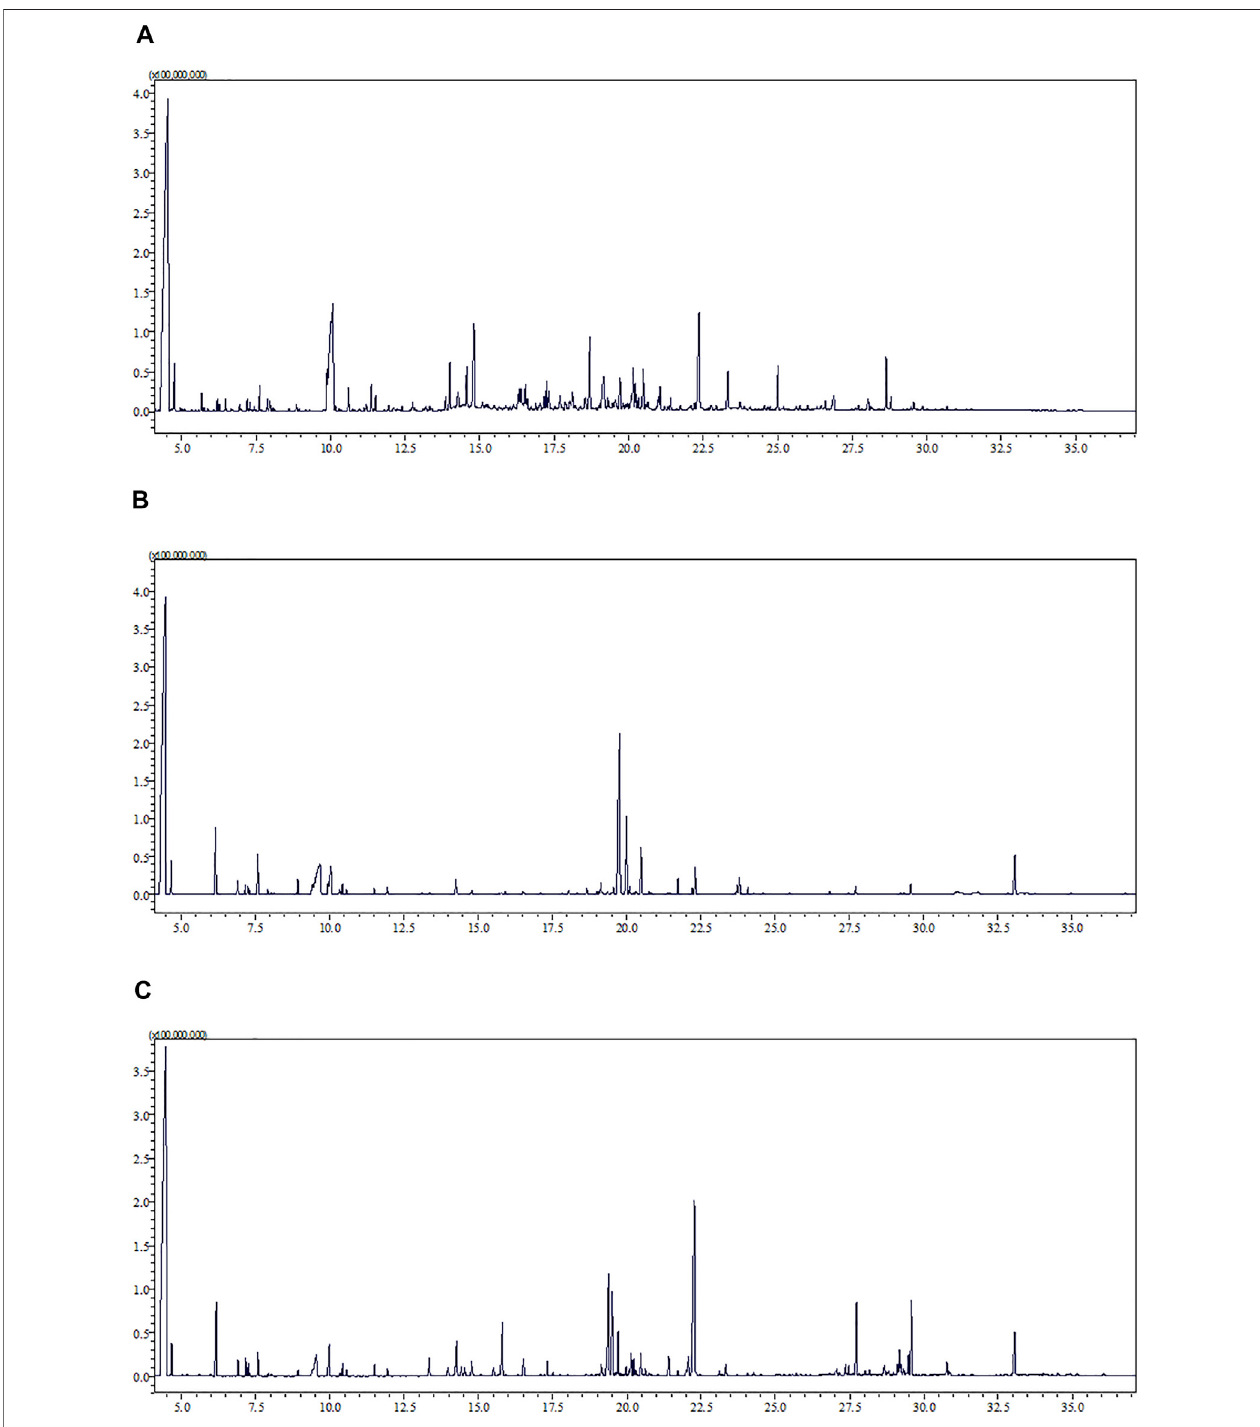
FIGURE 2 | Representative total ion chromatogram (TIC) of urine (A) , serum (B) , and semen (C) metabolic fi ngerprints obtained with GC – MS analysis.